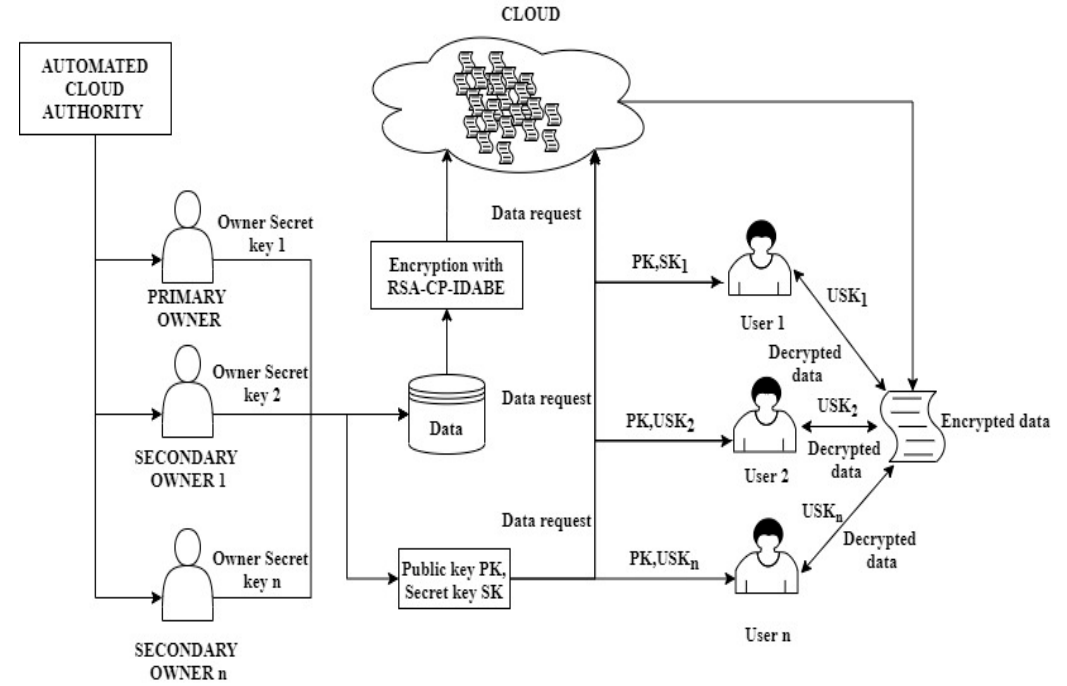
Figure 1. A proposed security framework for the cloud environment.